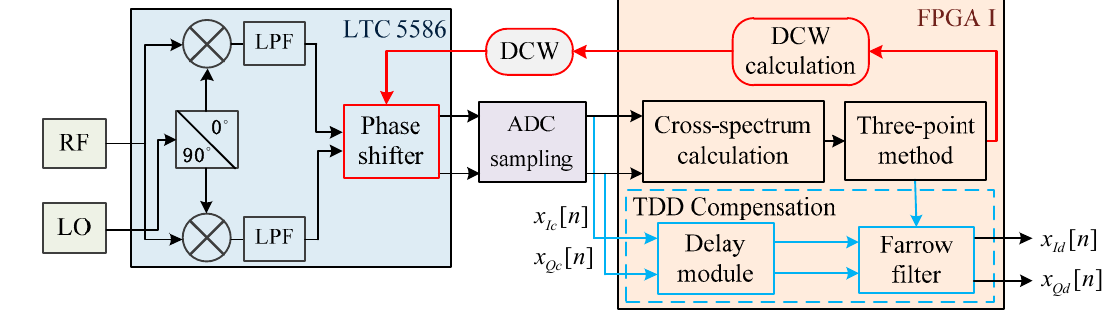
Figure 8. Block diagram of the compensation.